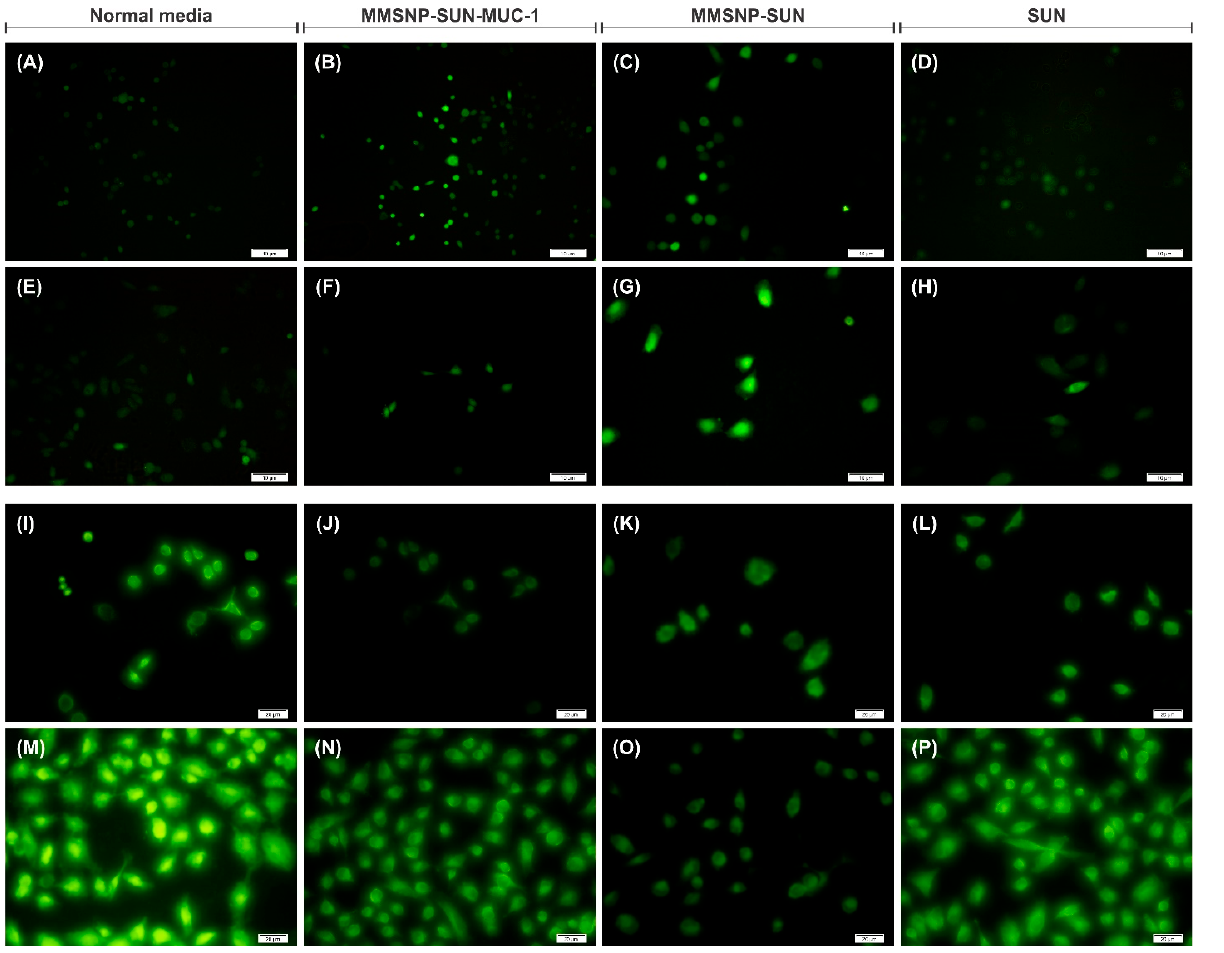
Figure 7. ROS production analysis on OVCAR-3 and MDA-MB-231 cells; sequentially treated with normal media as control ( A , E ), MMSNP-SUN-MUC-1 ( B , F ), MSNP-SUN ( C , G ) and SUN ( D , H ). Rhodamine 123 staining for the mitochondrial membrane potential analysis in OVCAR-3 and MDA- MB-231 cells; respectively treated with normal media as control ( I , M ), MMSNP-SUN-MUC-1 ( J , N ), MSNP-SUN ( K , O ) and SUN ( L , P ). The scale bar of images represents 20 μ m.